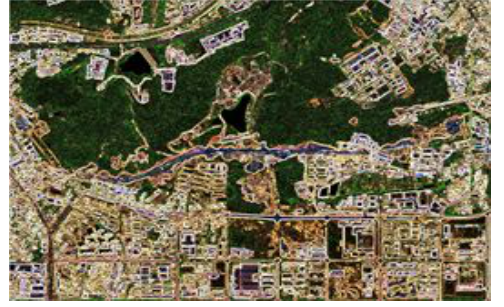
Figure 4. Sobe edge detection